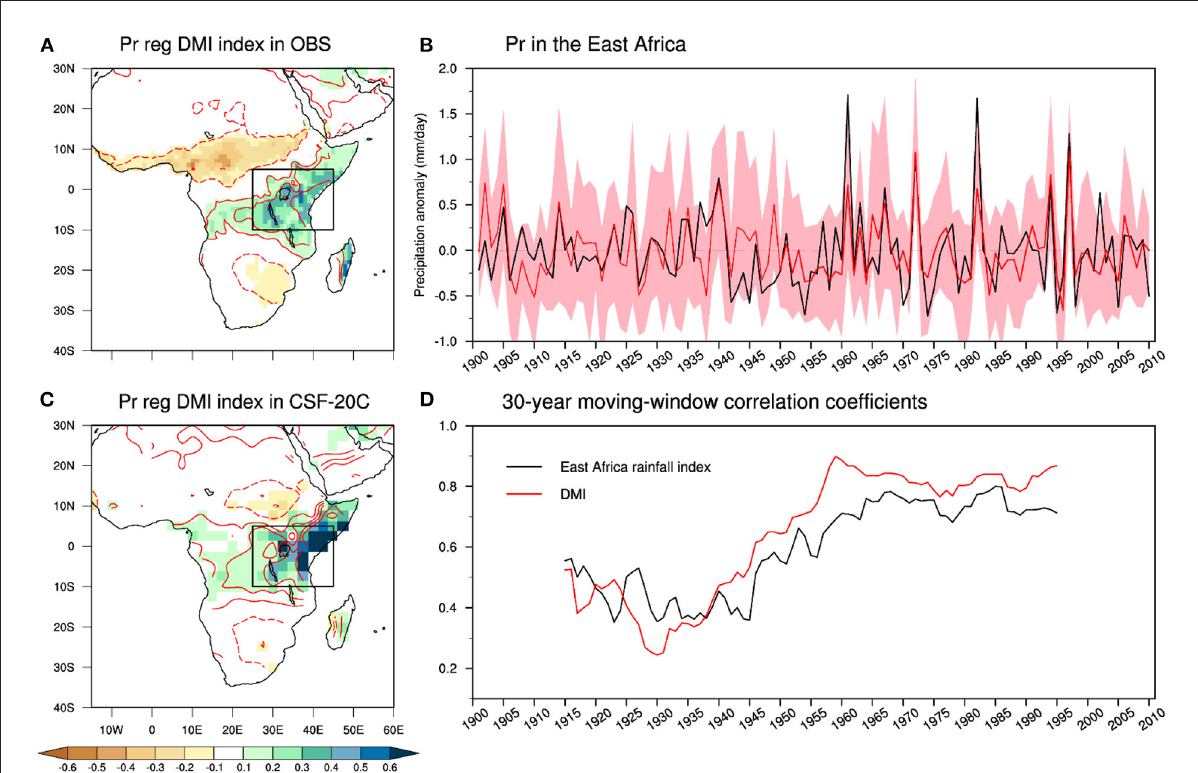
FIGURE9 Left: the correlation coefficient between the SON-mean DMI index and SON-mean land precipitation [red contour, the positive (negative) values are shown in solid (dashed) lines; zero contour is not shown; interval is 0.2], and the regression of SON-mean land precipitation (shading, unit: mm/day) onto the SON-mean DMI index for (A) observation, (C) ensemble mean prediction. Right: (B) the SON-mean East Africa rainfall index (rainfall anomalies averaged over 10 ◦ S-5 ◦ N, 25 ◦ E-45 ◦ E) in observations (black line) and the ensemble mean predictions from the CSF-20C (red line). The red shading indicates the ensemble spread. (D) the 30-year moving-window correlation coefficients between the ensemble mean prediction and the observations for the SON-mean East Africa rainfall index (black line), and the SON-mean DMI (red line). The correlation coefficients have been computed for 30-year windows moved across the period 1901–2010 by 1 year, and the correlations for each 30-year window are plotted at the central